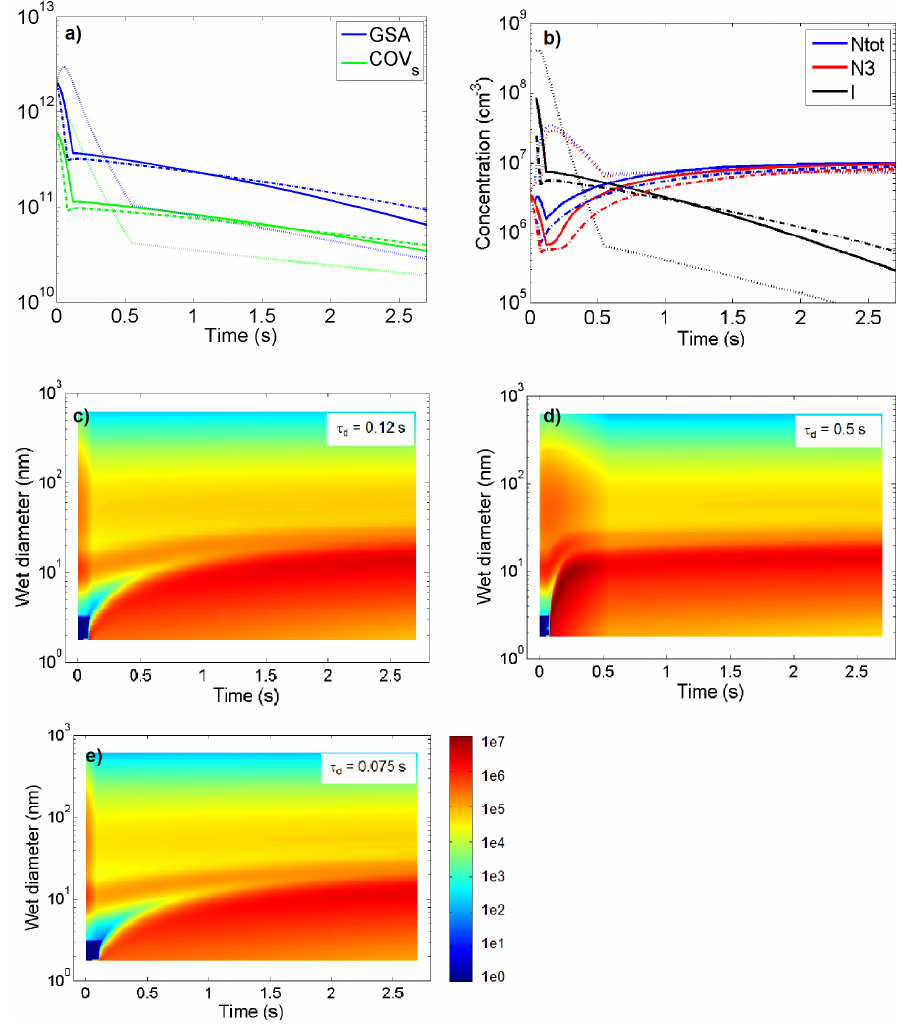
Figure 9. Effects of time constant ( τ d ) on time evolution of gases (a) , particle number and nucleation rate (b) and number size distribution (c) – (e) , where particle number concentration in cm − 3 is shown by colour bar. In (a) and (b) , solid curves refer to τ d = 0.12s (base case), dotted curves to τ d = 0.5s, and dash-dotted curves to τ d = 0.075s. The nucleation mechanism for these simulations was